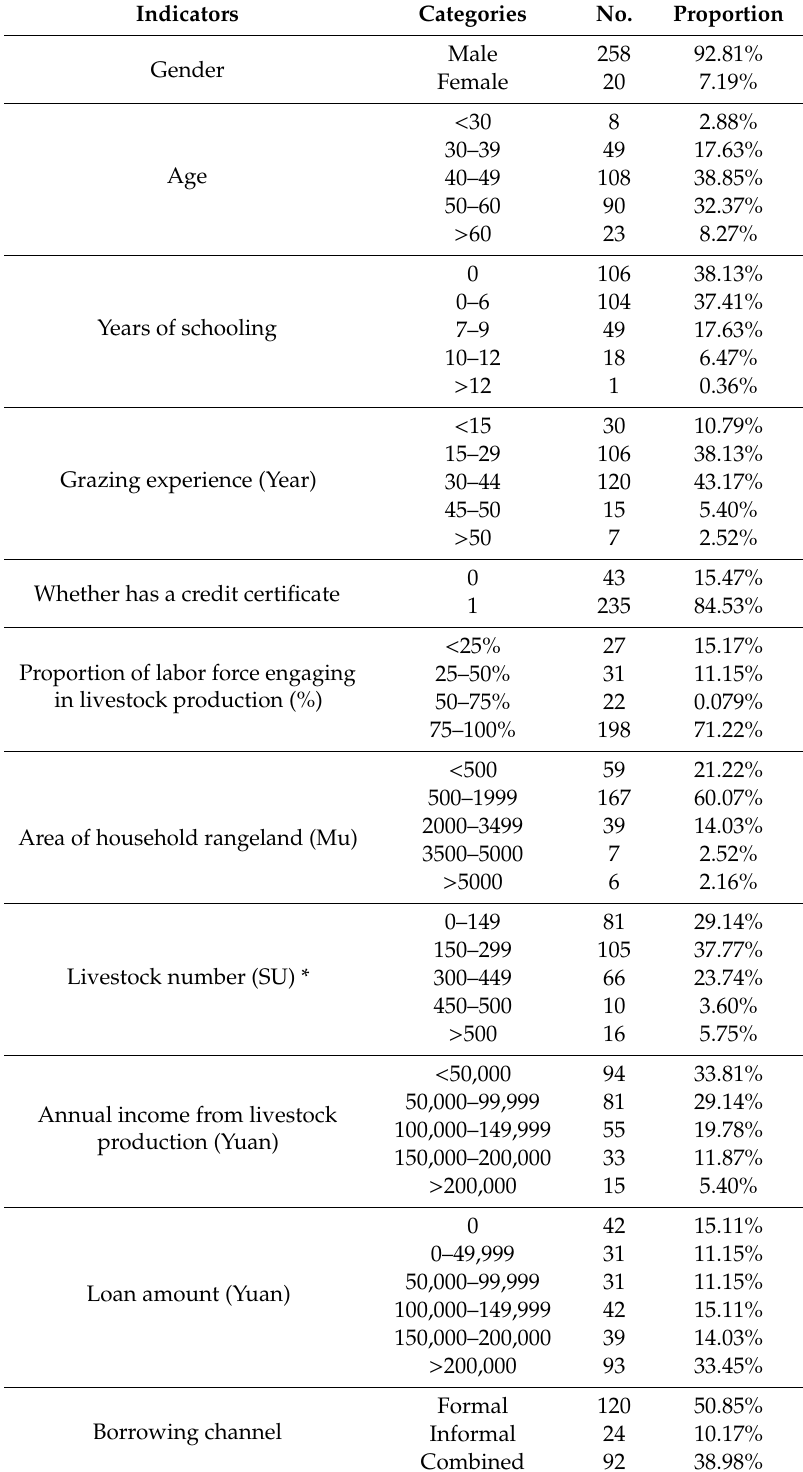
Table 1. Descriptive statistics of sample herders /